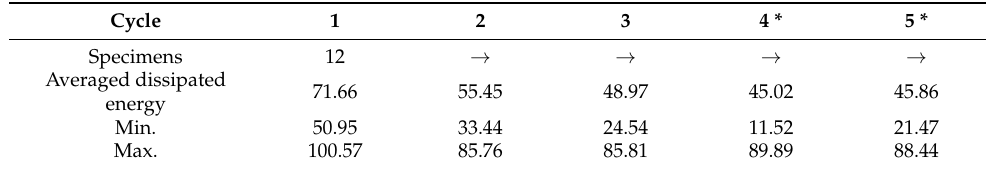
Table A2. Average energy dissipation per cycle (five cycles of 1010 kN after 5-785 kN cycles) (unit = kN · mm). Cycle